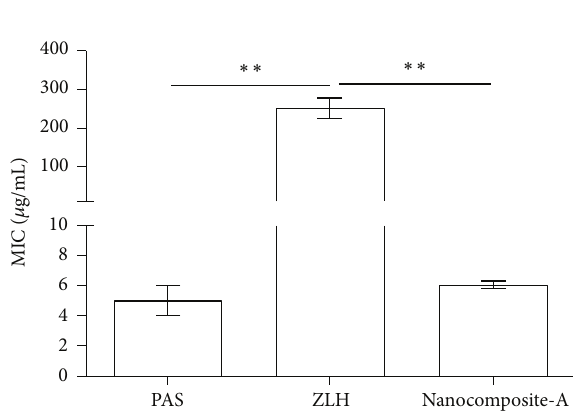
Figure 9: Minimum inhibitory concentrations ( 𝜇 g/mL) (MICs) of PAS-ZLH (Nanocomposite A) as compared to PAS against Mycobacterium tuberculosis determined bythemycobacteria growth indicator tube (MGIT) with BACTEC MGIT 960 growth sup- plement for drug susceptibility testing (DST) and measured by the MGIT 960 instrument (Becton Dickinson Diagnostic Systems, Sparks, MD,